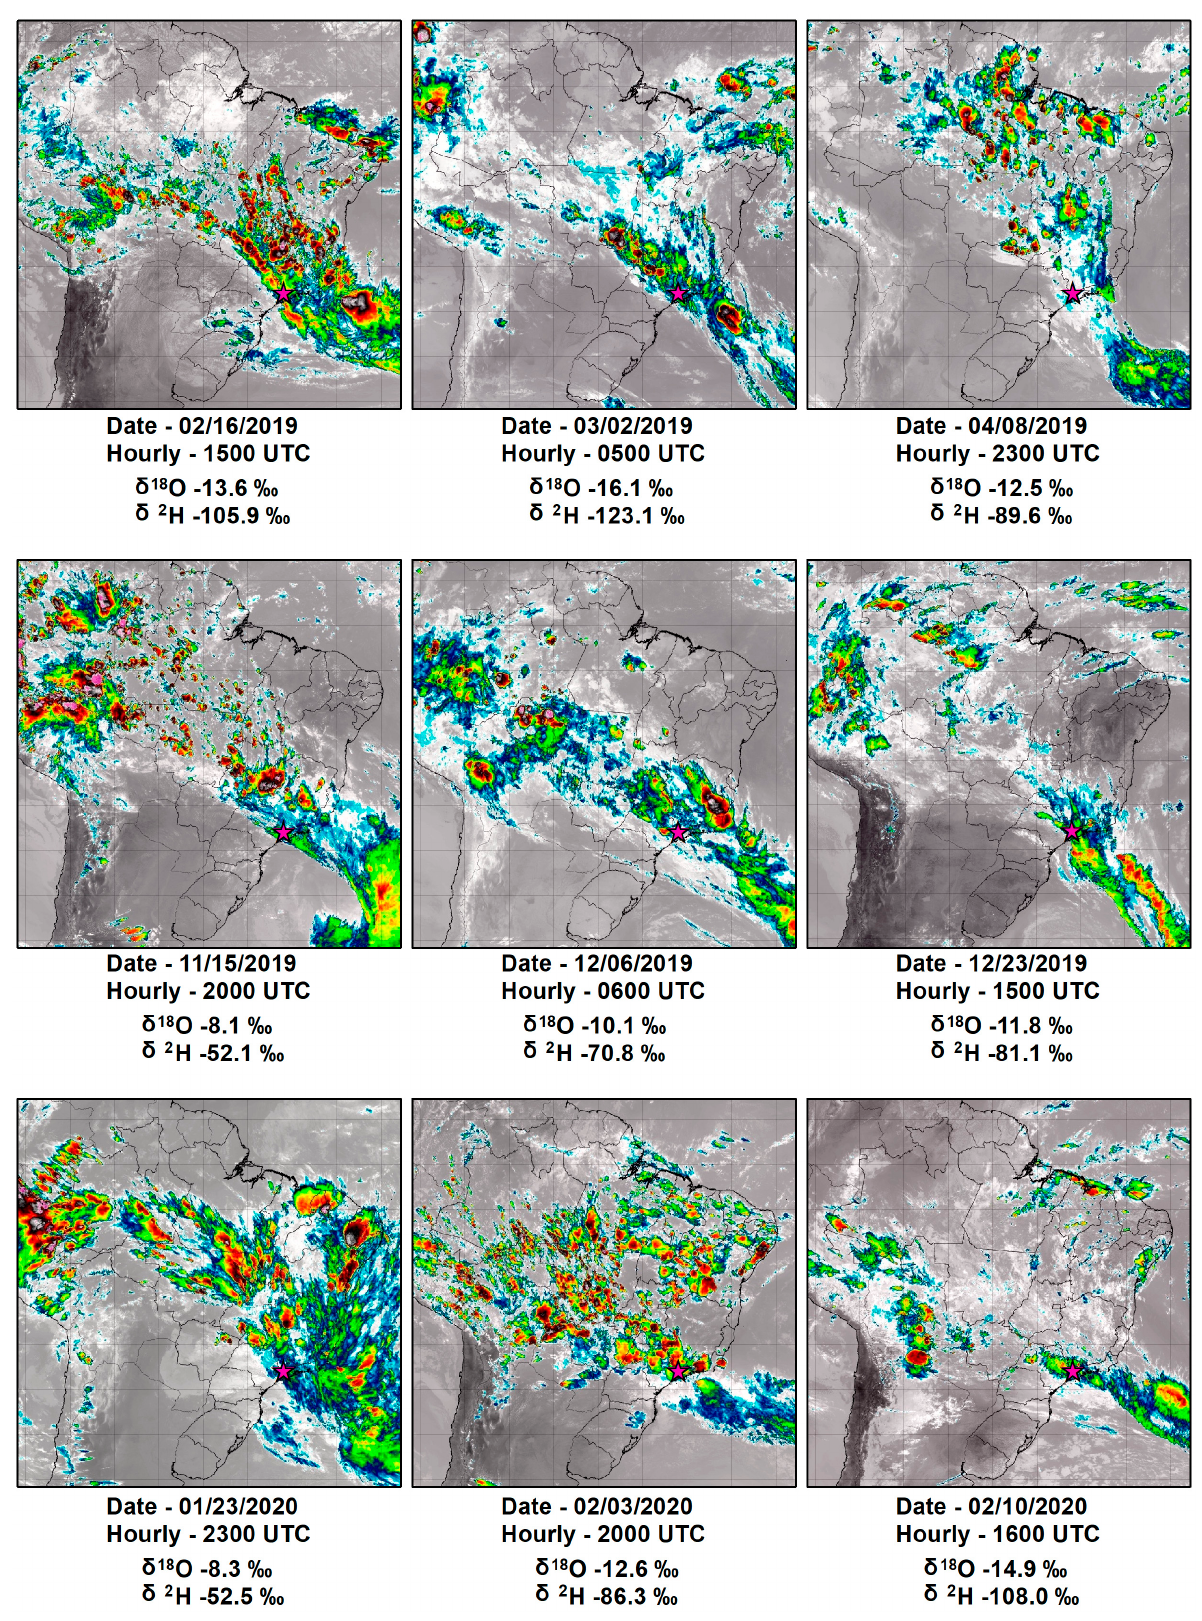
Figure 5. Infrared images from the GOES-16 satellite on the days when the SACZ was active in SFX (magenta star). Images selected on days and times when the precipitation collection presented more depleted isotopic signals for each SACZ